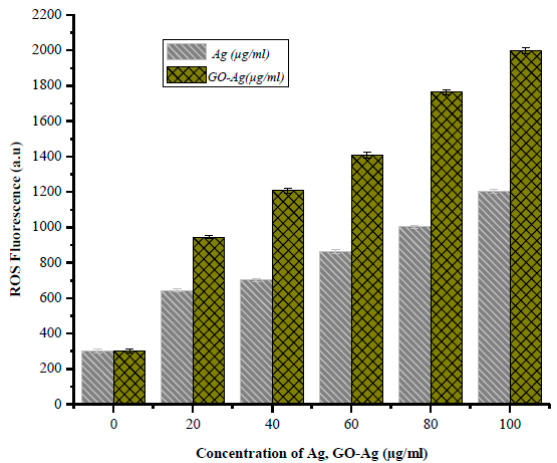
Figure 9. ROS Fluorescence in MCF-7 cells Model after Labeling with Ag NPs and GO-Ag (microgram/mL).